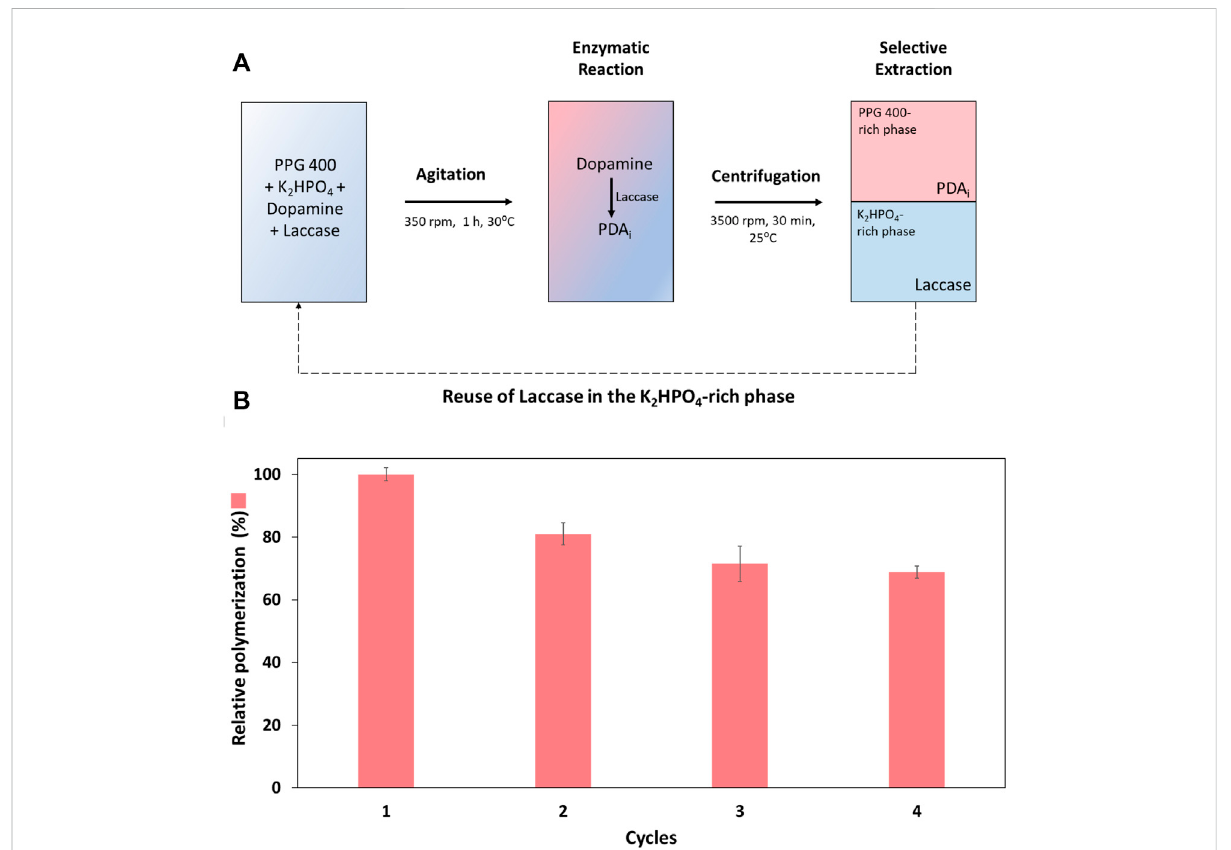
FIGURE 5 (A) Scheme of the integrated reaction — extraction process developed by applying ABS consisting of PPG 400 and K 2 HPO 4 , 30 ° C, including the recycling of the laccase and the K 2 HPO 4 -rich phase. (B) Relative dopamine polymerization (%) in four reaction cycles of the polymerization reaction (in relation to the fi rst